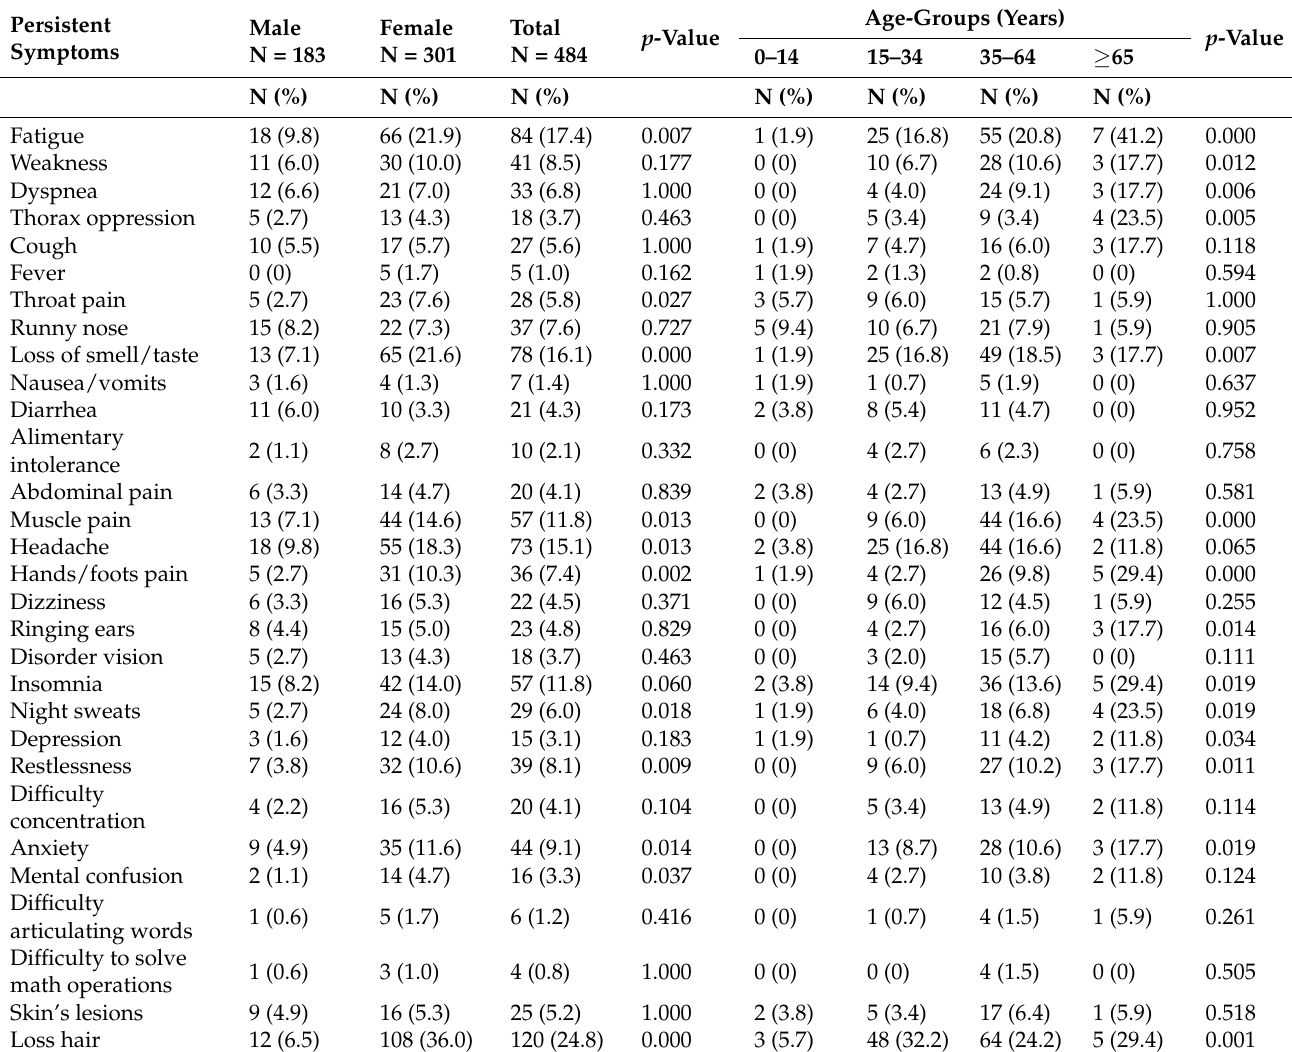
Table 2. Reported persistent post-COVID-19 symptoms of participants by sex and age. Borriana COVID-19 cohort